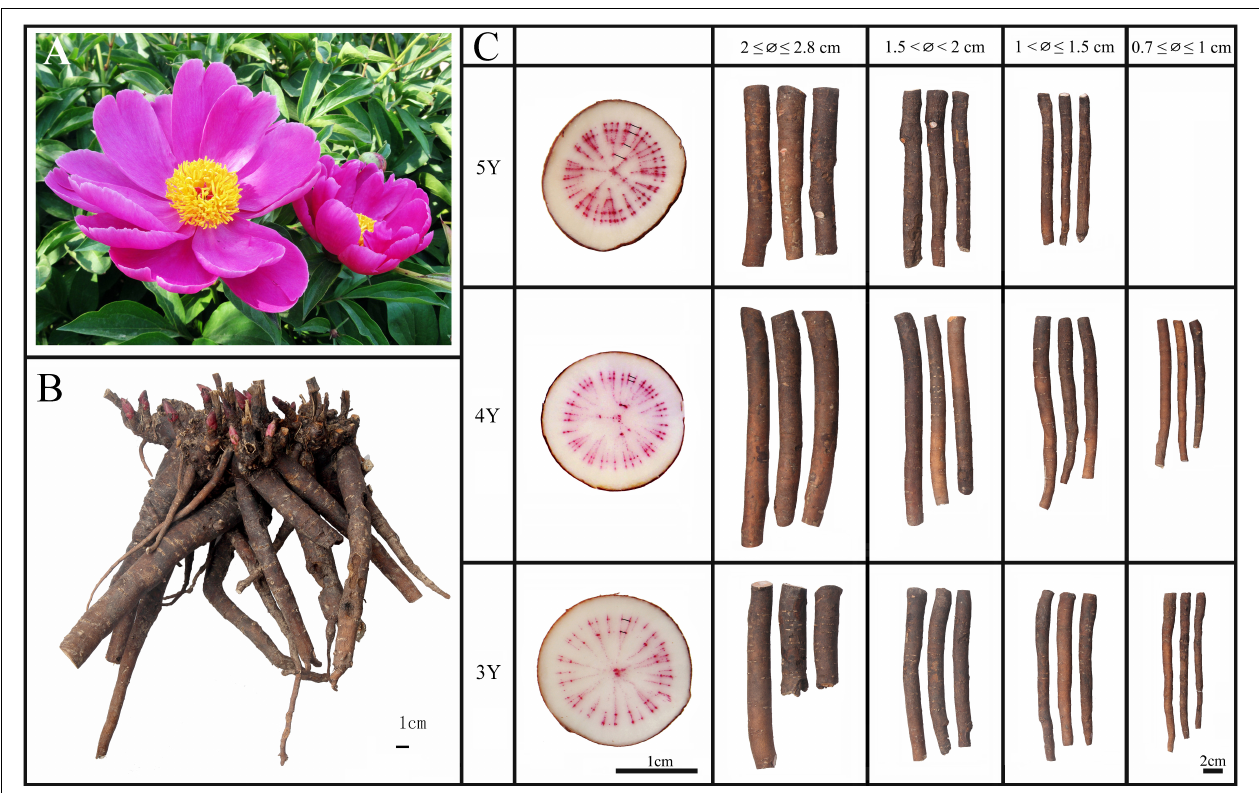
FIGURE 1 | Characteristics of flower (A) , root system (B) , and roots of different ages and diameter of P. lactiflora (C) . 3Y, 3-year-old roots of P. lactiflora ; 4Y, 4-year-old roots of P. lactiflora ; 5Y, 5-year-old roots of P. lactiflora ; ∅ , median diameter of P. lactiflora roots.